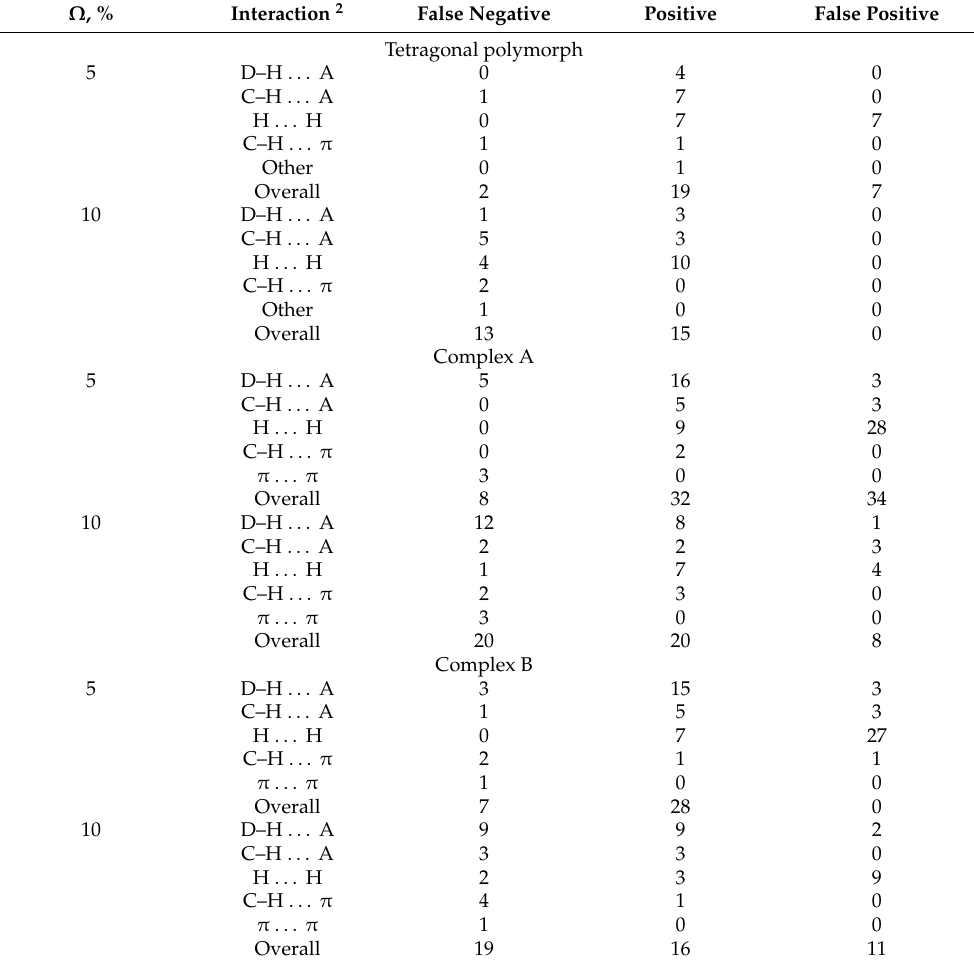
Table 3. The dependence between “direct” interactions with high solid angles and the presence of a bcp for these interactions 1 .